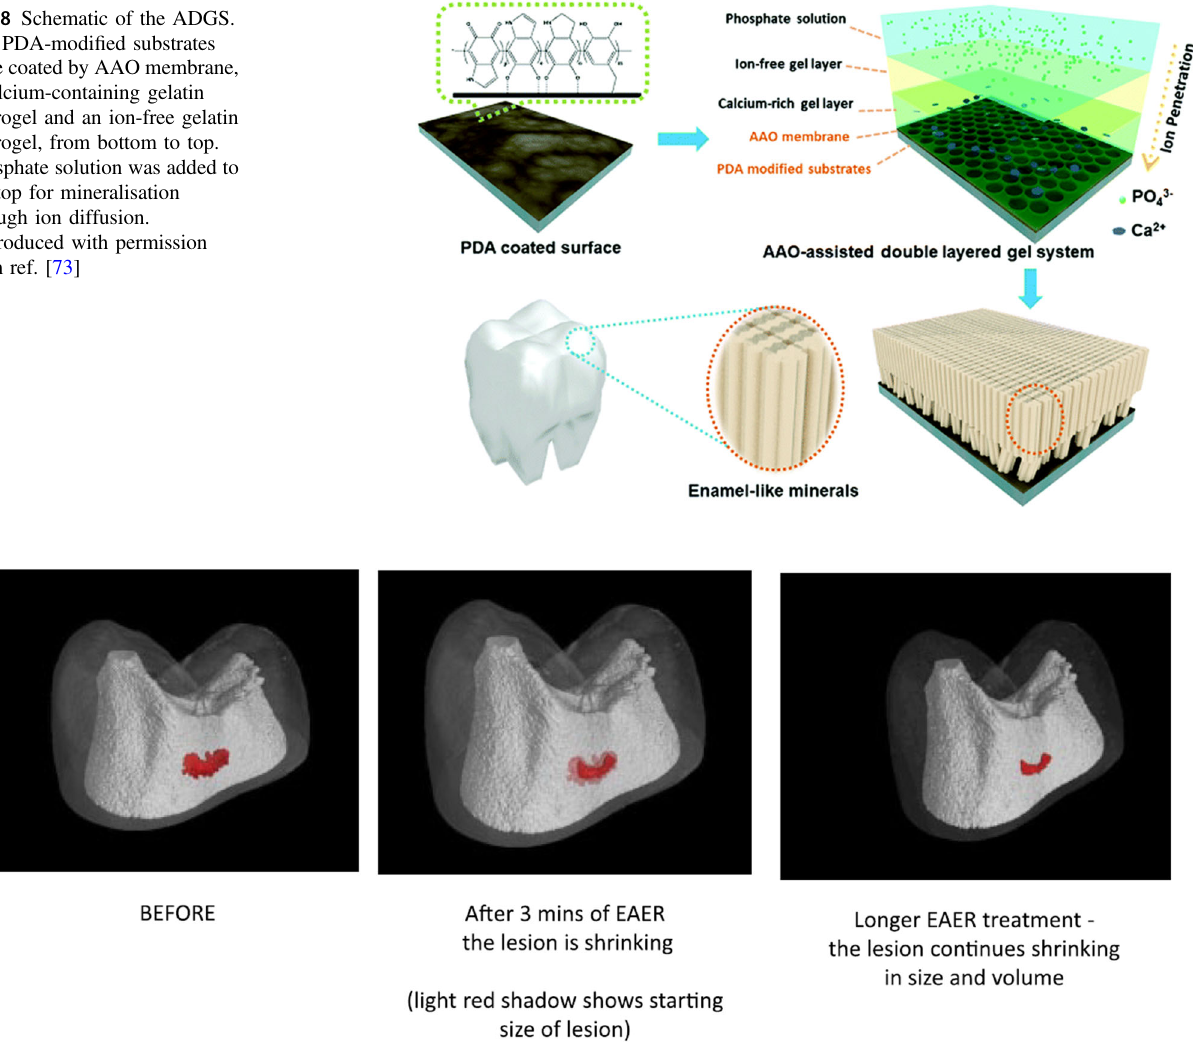
Fig. 9 Three-dimensional X-ray mercury cadmium telluride images of an EAER-treated lesion. EAER-treated lesion reducing in volume and size. The red colouring represents the area of the enamel lesion that had a calculated mineral density ≥ 5% lower than the surrounding ‘ healthy ’ enamel